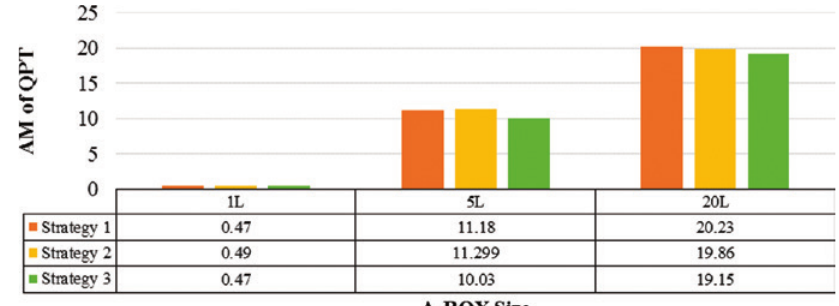
Figure 11: AM Analysis of Three Strategies.